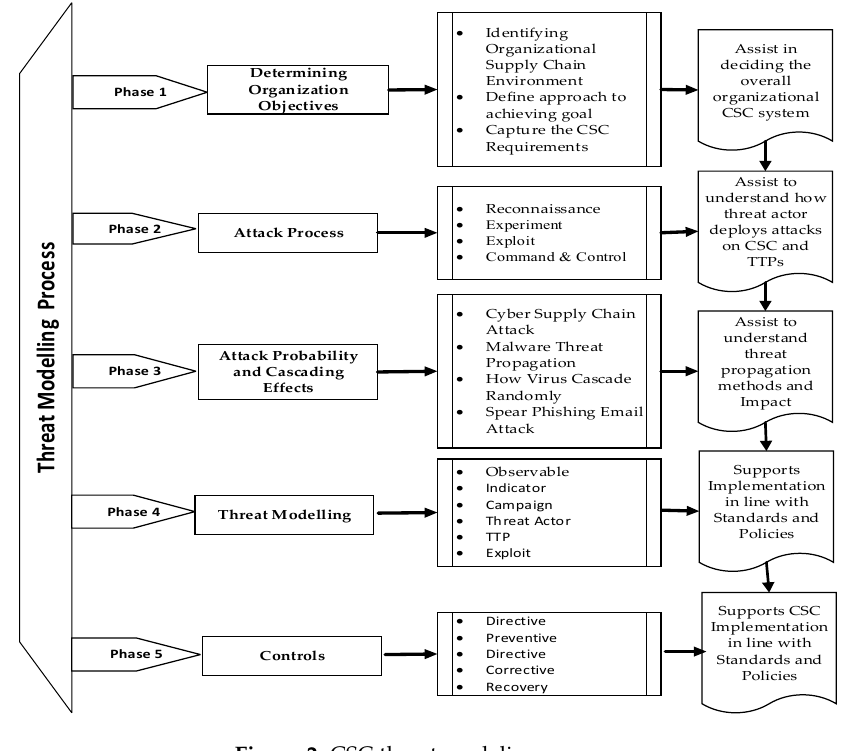
Figure 2. CSC threat modeling process.